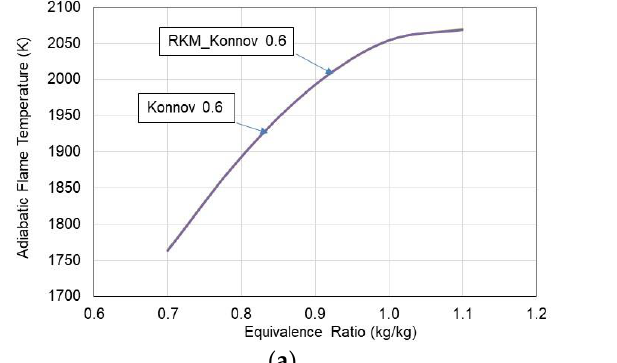
Figure 2. Adiabatic flame temperature ( a ) and NO, NO 2 fractions ( b ) vs. equivalence ratio for Konnov and RKM_Konnov mechanisms.